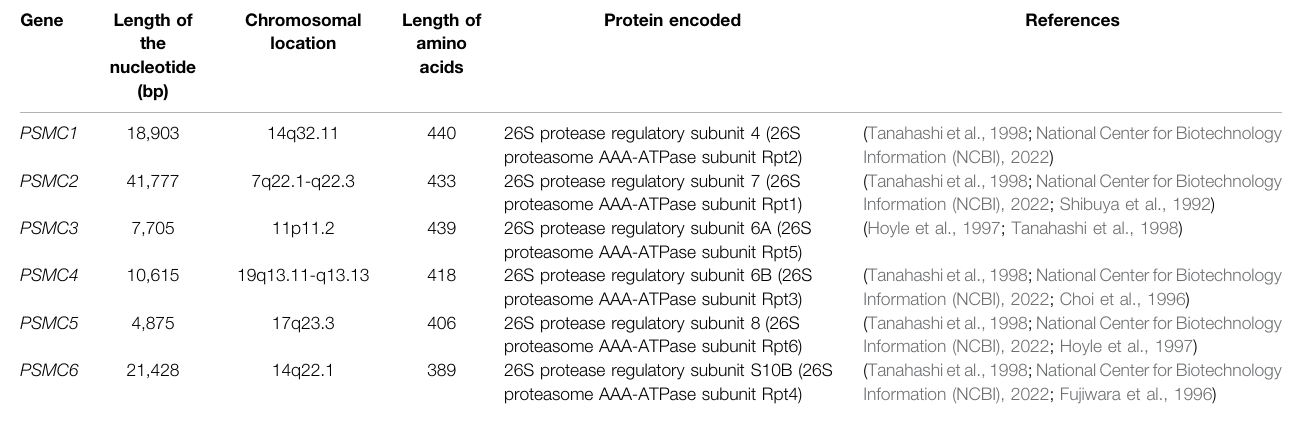
TABLE 1 | Genomic characteristics of all the subunits in the PSMC gene